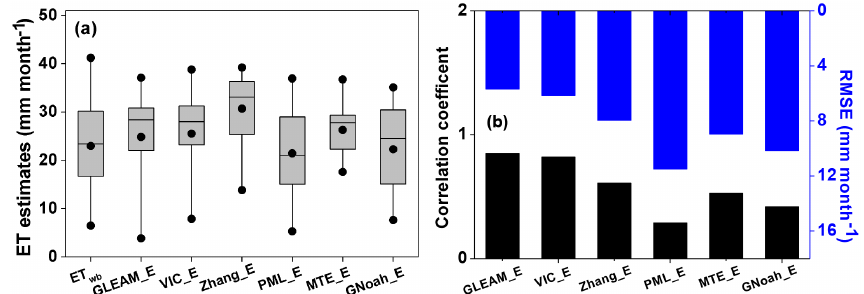
Figure 3. Comparison of different ET products against the calculated ET through the water balance method (ET wb ) on the monthly timescale for 18 TP basins during the period 1983–2006. The box plot of monthly estimates of different ET products for 18 TP basins are shown in (a) , while the correlation coefficients and root mean square errors (RMSEs, mmmonth − 1 ) for each ET product relative to ET wb are exhibited in (b)